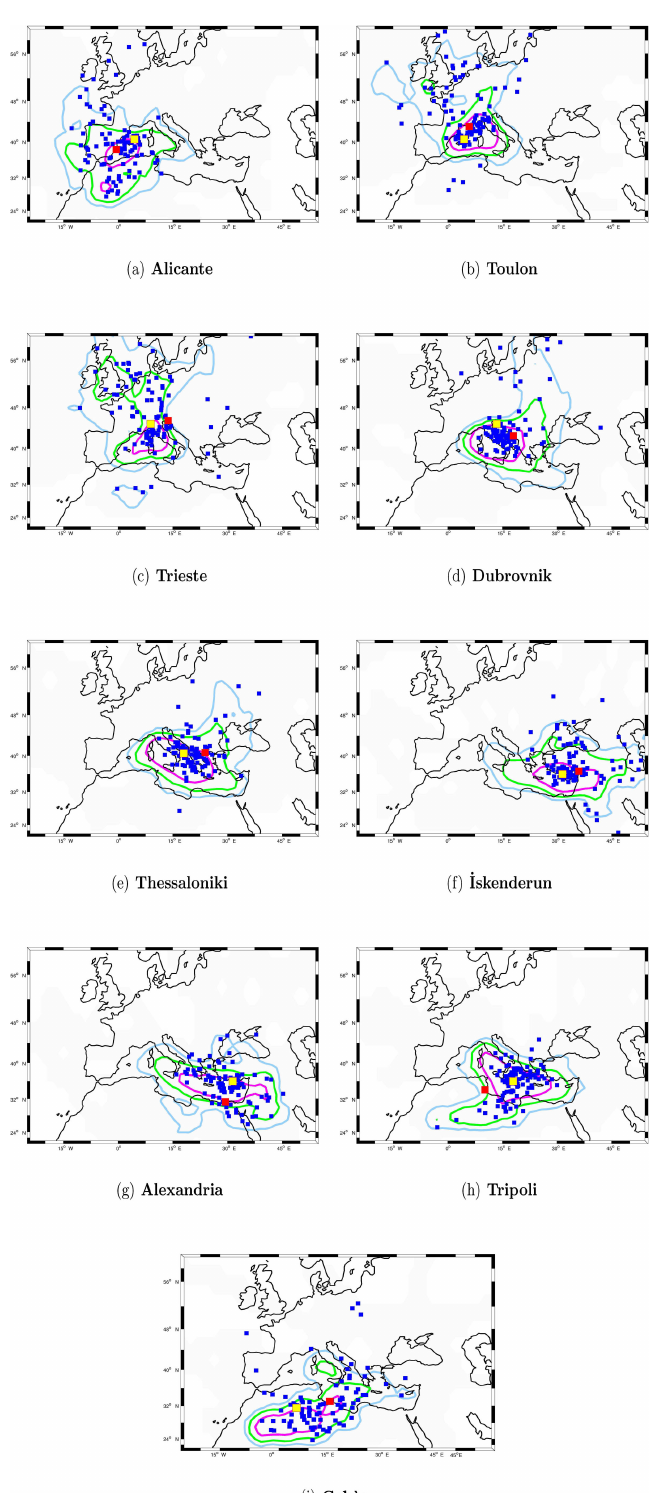
Figure 6. Track density of cyclones producing large sea level anomalies at Alicante (a) , Toulon (b) , Trieste (c) , Dubrovnik (d) , Thessa- loniki (e) , ˙ Iskenderun (f) , Alexandria (g) , Tripoli (h) and Gabès (i) (locations are denoted with a red square). Blue squares show the position of the cyclone centres at the peak of the sea level anomaly. The yellow squares denote the reference position used in Table 2 and Sect. 3.4. A smoothing radius of 5 ◦ is applied to the original data resolution (1.5 ◦ ). Contour lines are drawn at the 25 × 10 − 7 (blue line), 0 . 5 × 10 − 7 (green line) and 1 × 10 − 7 (magenta line) levels. The units used are probability per square